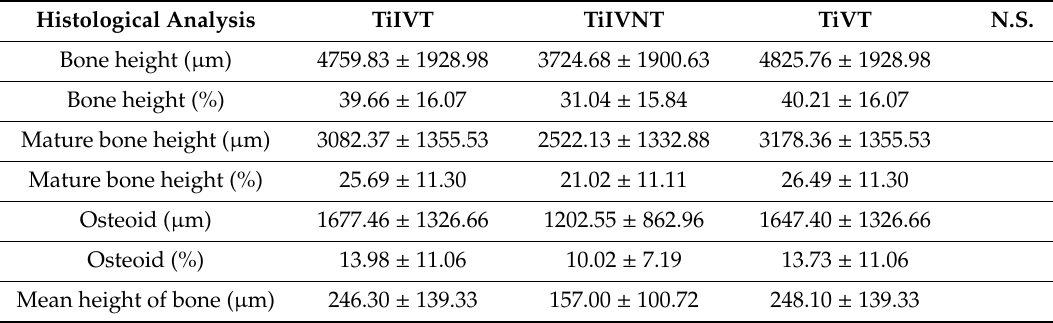
Table 4. Histological